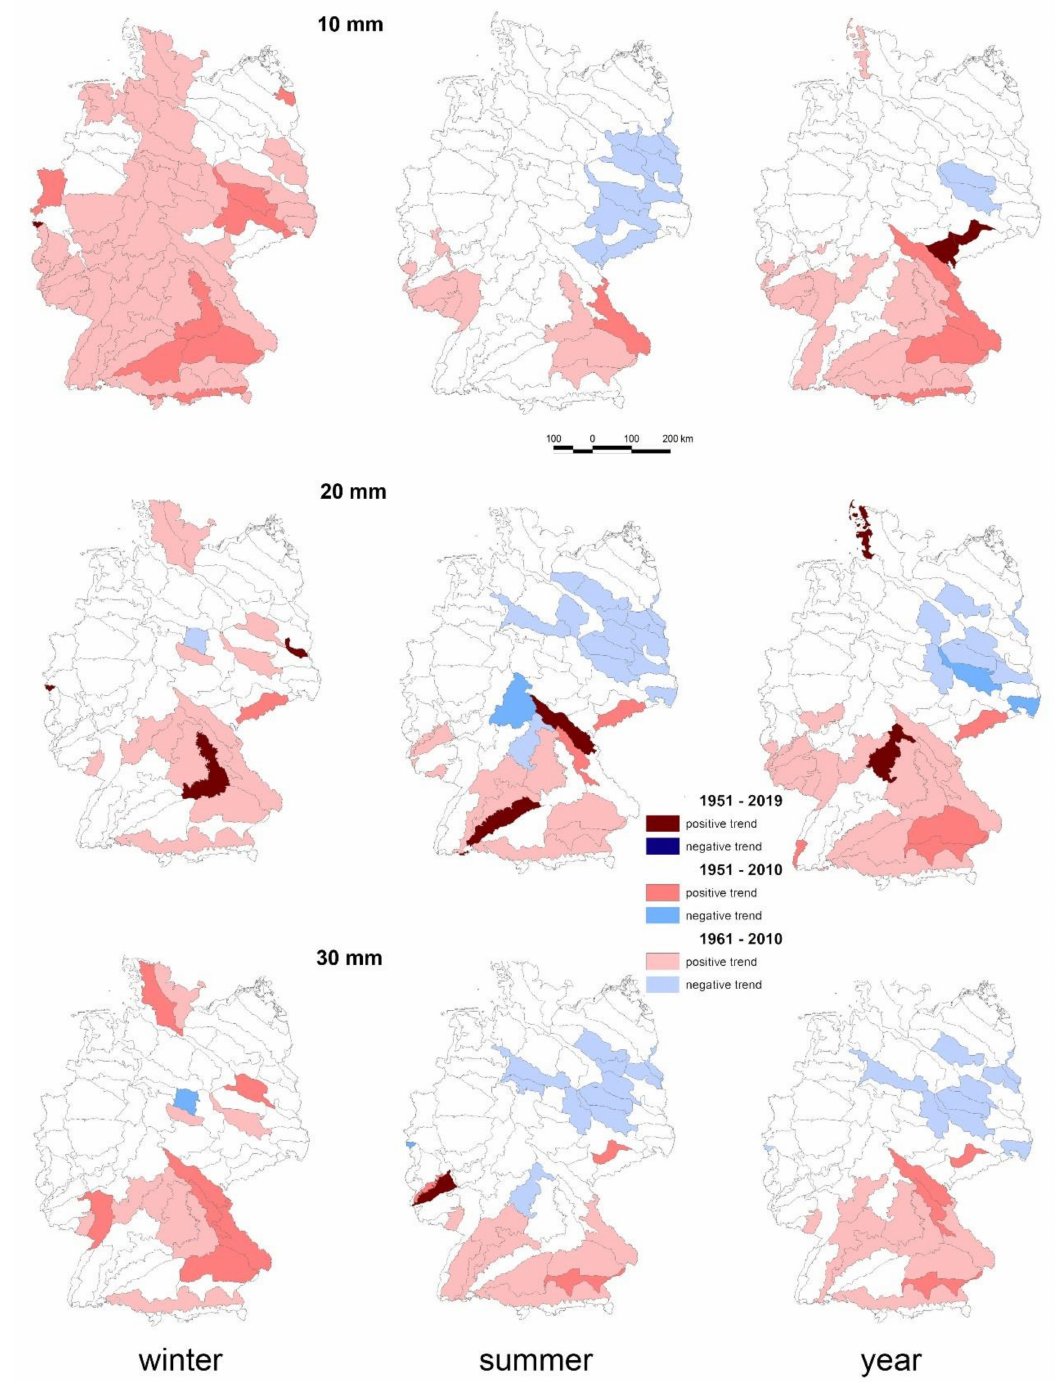
Figure 7. Dominantly increasing (red) and decreasing (blue) trends of heavy rainfall days in German natural regions, for di ff erent thresholds (rows), seasons (columns), and periods (color), (cf. Table A2 in Appendix